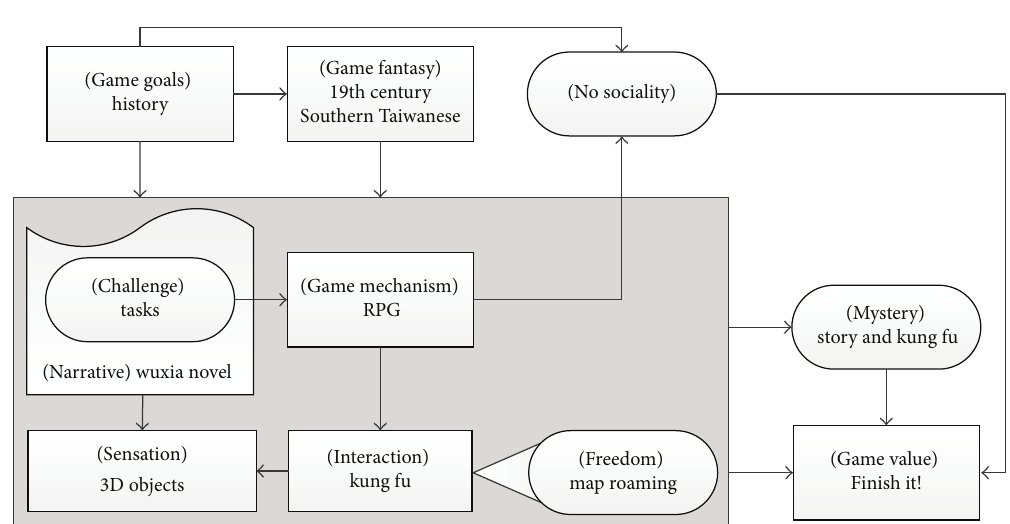
Figure 7: GBL design model for Xiao-Mao